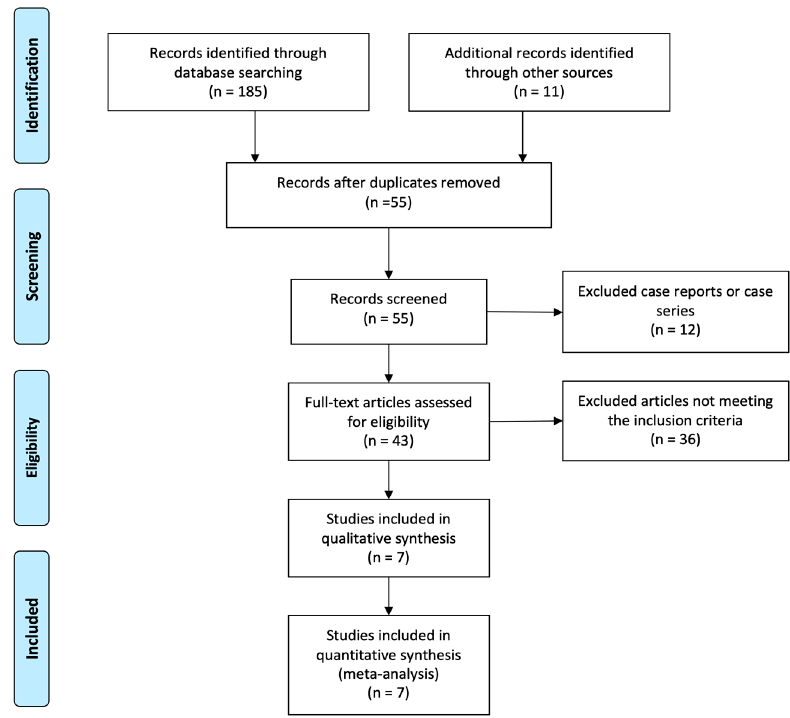
Figure 1. PRISMA flowchart, depicting the studies selection criteria.